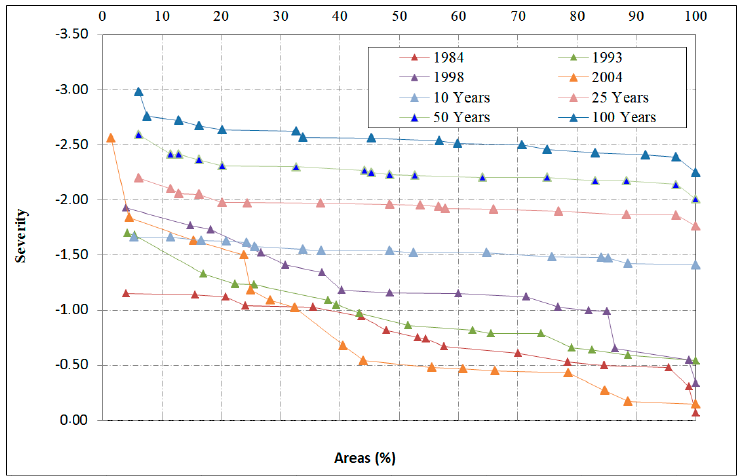
Table 6. Frequency of each drought and wetness class for the considered stations, %.